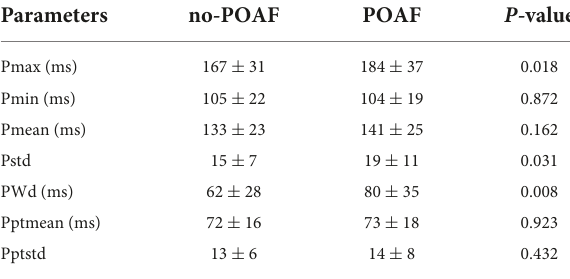
TABLE 2 Comparison of preoperative ECG P-wave characteristic.